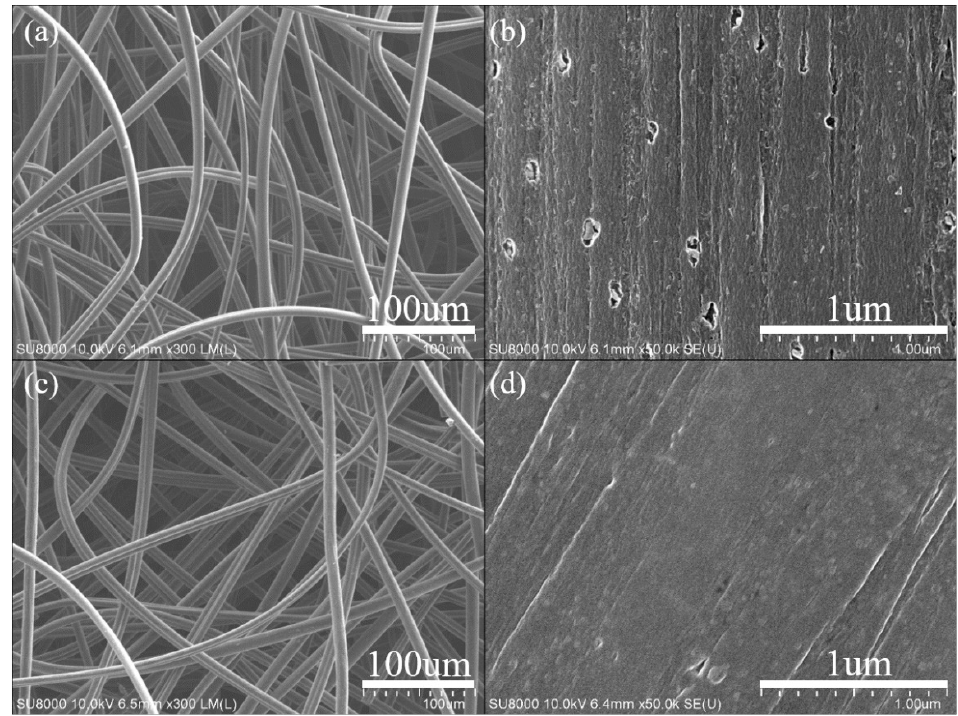
Figure 3. SEM images of original graphite felt ( a , b ) and atomic layer deposition (ALD)-TiO 2 -modified graphite felt ( c , d ).